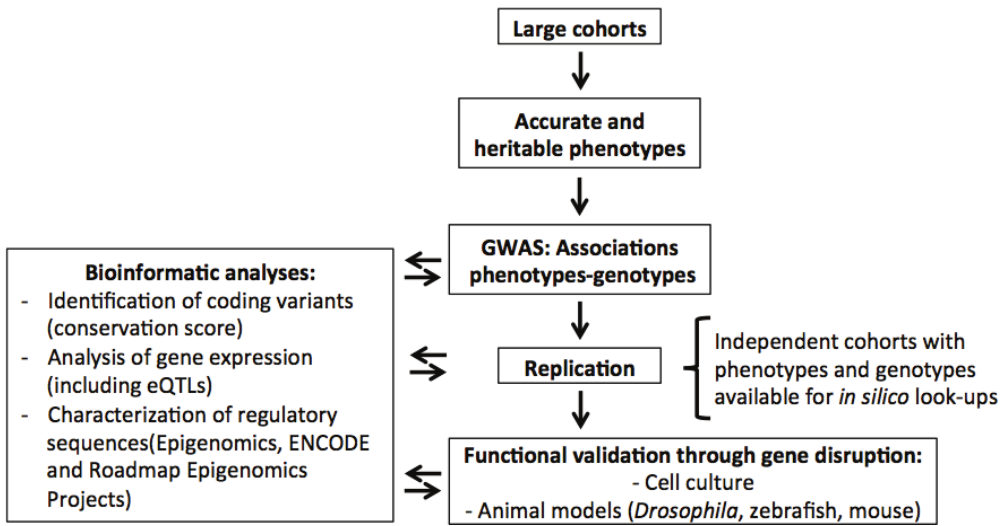
Figure 1. Ideal study design to identify single nucleotide polymorphisms (SNPs) associated with human complex traits and diseases using genome-wide association studies (GWAS). For blood cell phenotypes, GWAS were particularly successful because sample sizes are large, phenotypes are easy to measure and are accurate, and well-characterized experimental models already